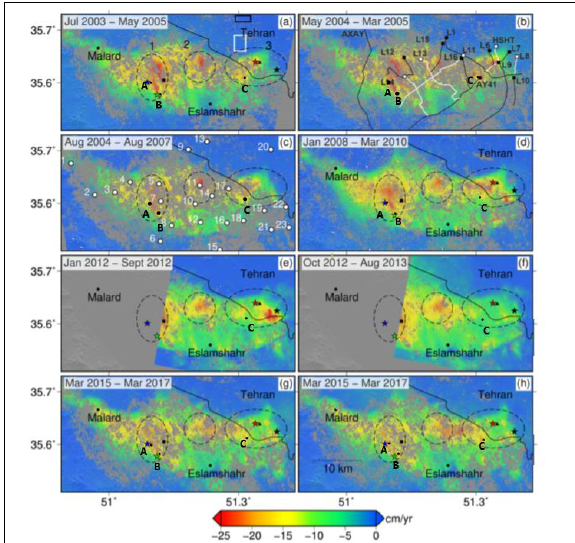
Figure 2. Average subsidence rates in the southwest of Tehran (Motagh et al.,